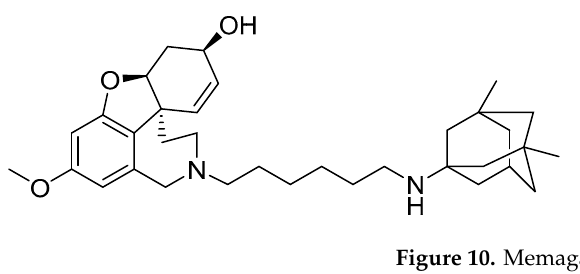
Figure 10. Figure 10. Memagal. Figure 10. Memagal.